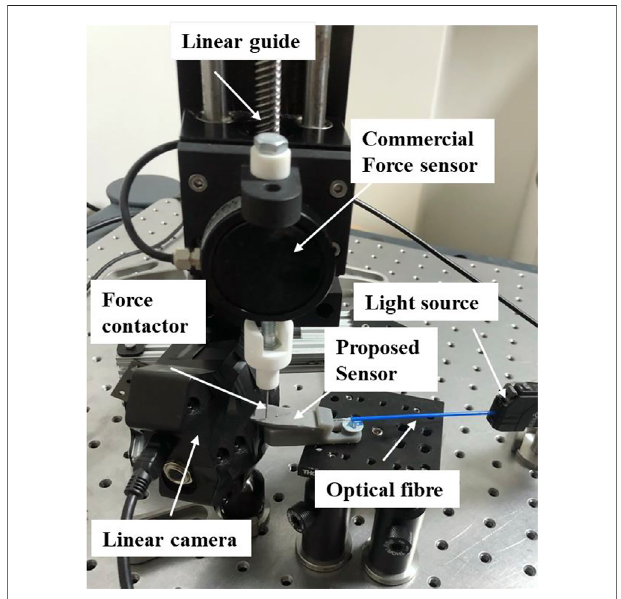
FIGURE 7 | The experimental setup consists of a light source, a force contactor, the proposed sensors, a motorized linear guide, a load cell force sensor and a linear